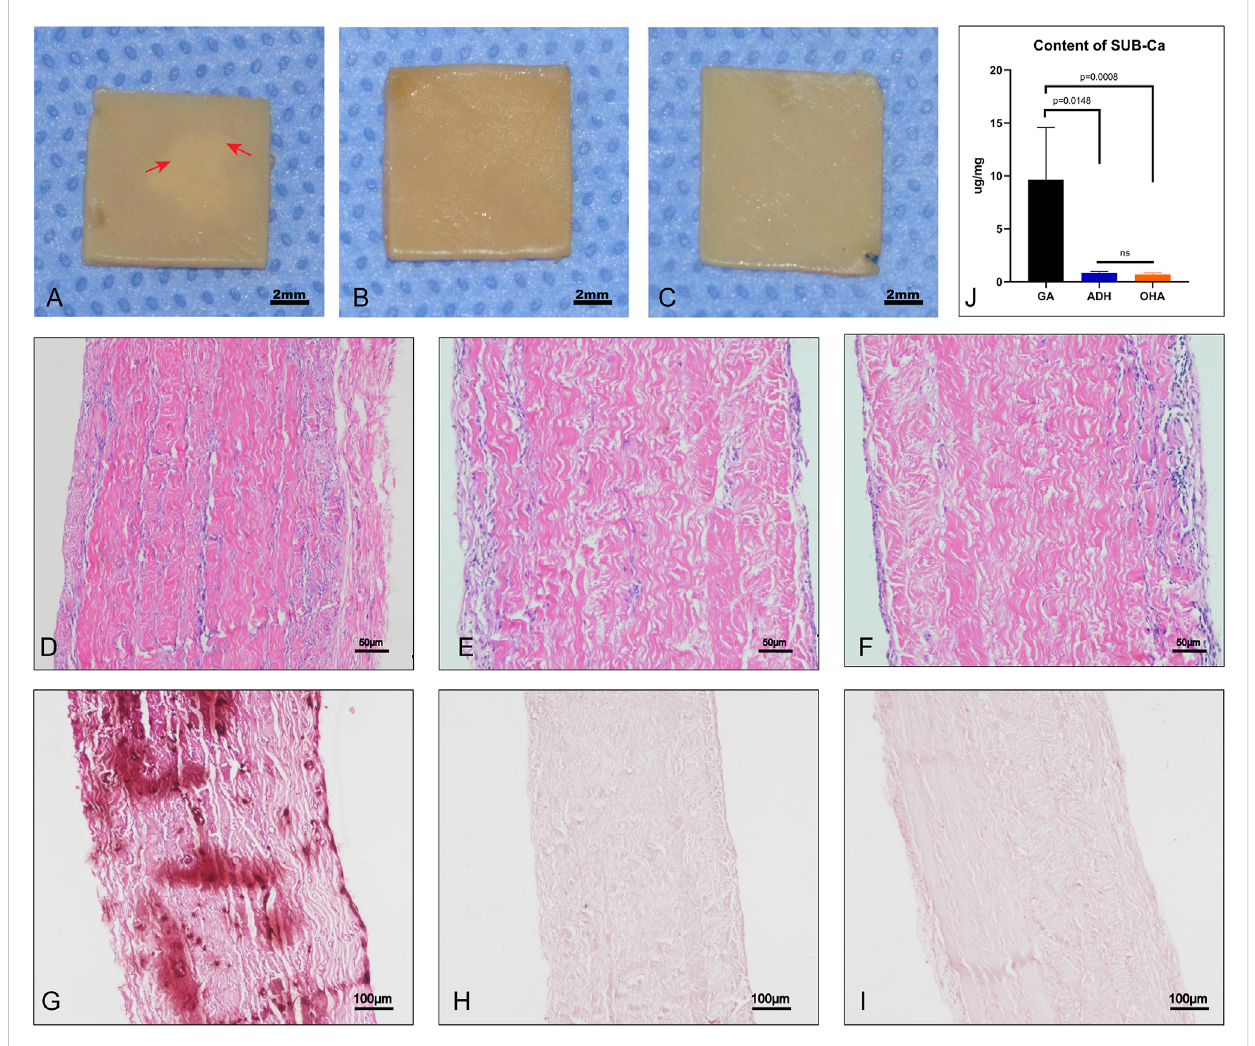
FIGURE 9 Gross specimens, histological characteristics and quantitative analysis after subcutaneous implantation for 60 days. Signi fi cant calci fi cations could be observed in the pericardium of the GA group (A) , whereas no calci fi cations were observed in the ADH and OHA groups (B, C) . The images show HE staining (D – F) . Alizarin red staining showed that the GA group (G) had more calcium deposition (dark red) than the ADH and OHA groups (H, I) . The calcium quantitative analysis showed that the calcium content of the ADH and OHA groups was signi fi cantly lower than that of the GA group (J)